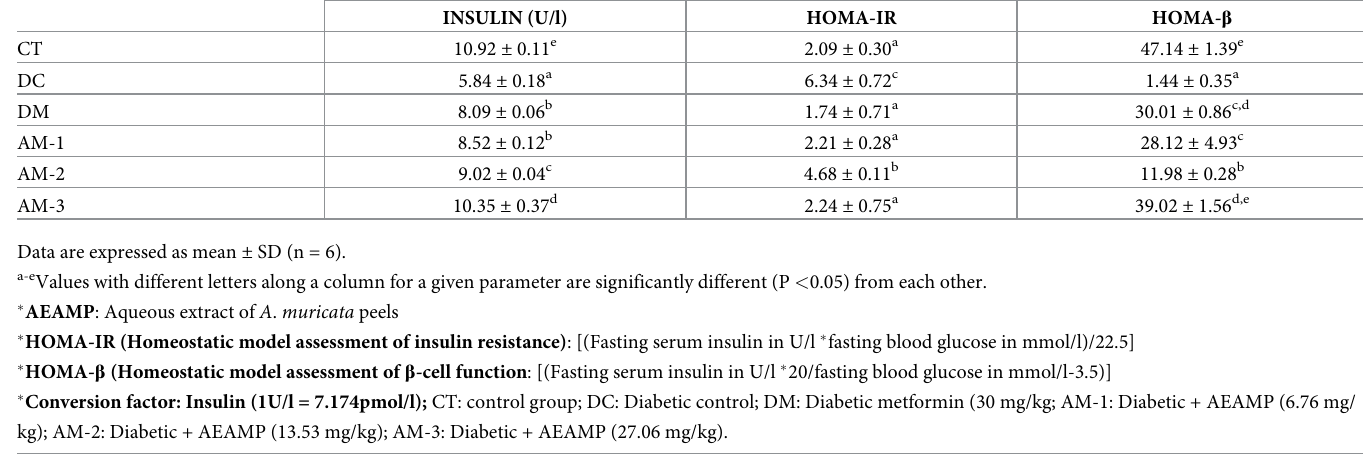
Table 5. Serum insulin levels, HOMA-IR and HOMA- β scores of alloxan-induced diabetic rats after oral administration of aqueous extract of A . muricata peels. GROUPS